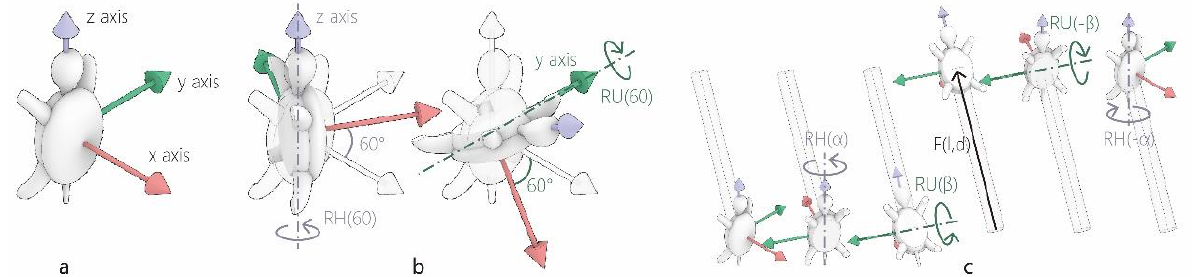
Figure 5. Turtle state and Euler rotation in the interpretation of pipelines. ( a ) the initial heading of the turtle in Language XL; ( b ) rotating the turtle’s heading along its z and y axis with command RH ( α ) and RU ( β ), respectively; ( c ) visualization of one set of commands for describing one single pipeline.